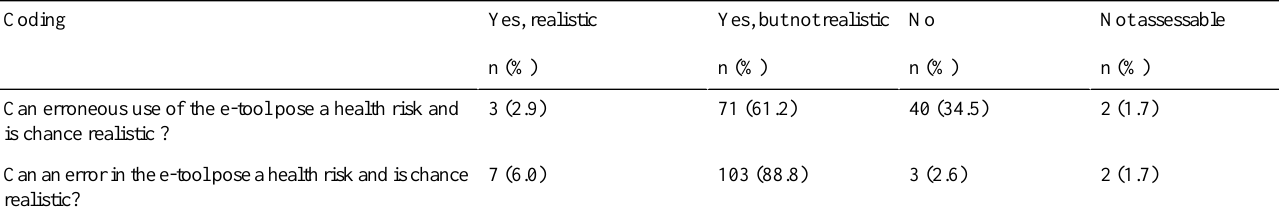
Table 3. Assessment of possible risks of apps and other e-tools for medication use, when errors (in use or the tool) are present; data is presented as percentage of total number of tools investigated